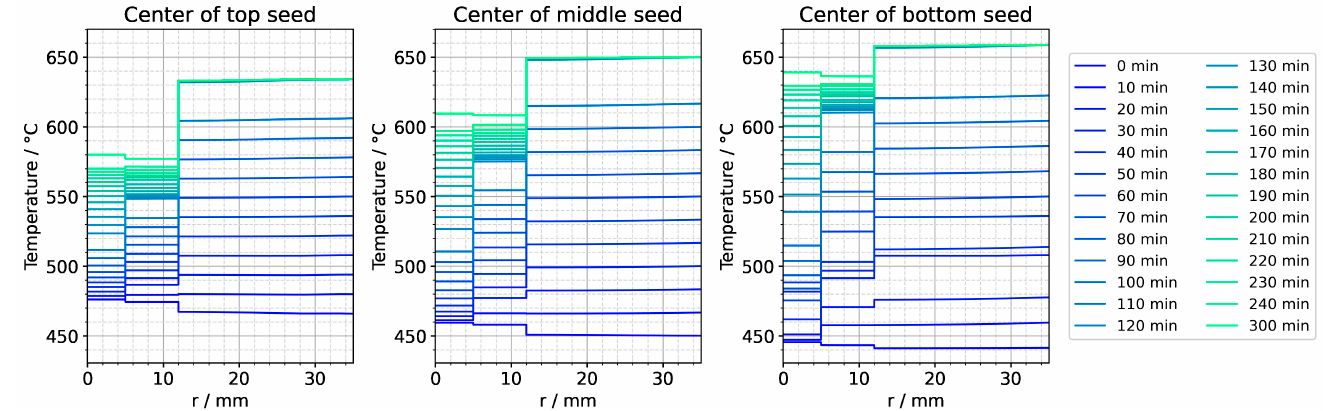
Figure A4. Temperature distribution in horizontal direction through the center of each seed for the entire set temperature inversion process. The quasi-stable conditions of etch-back stage are present at the time 0 min. The time 120 min represents the moment at which set temperatures have reached their values for growth stage. The time 300 min corresponds to quasi-stable conditions of growth stage.